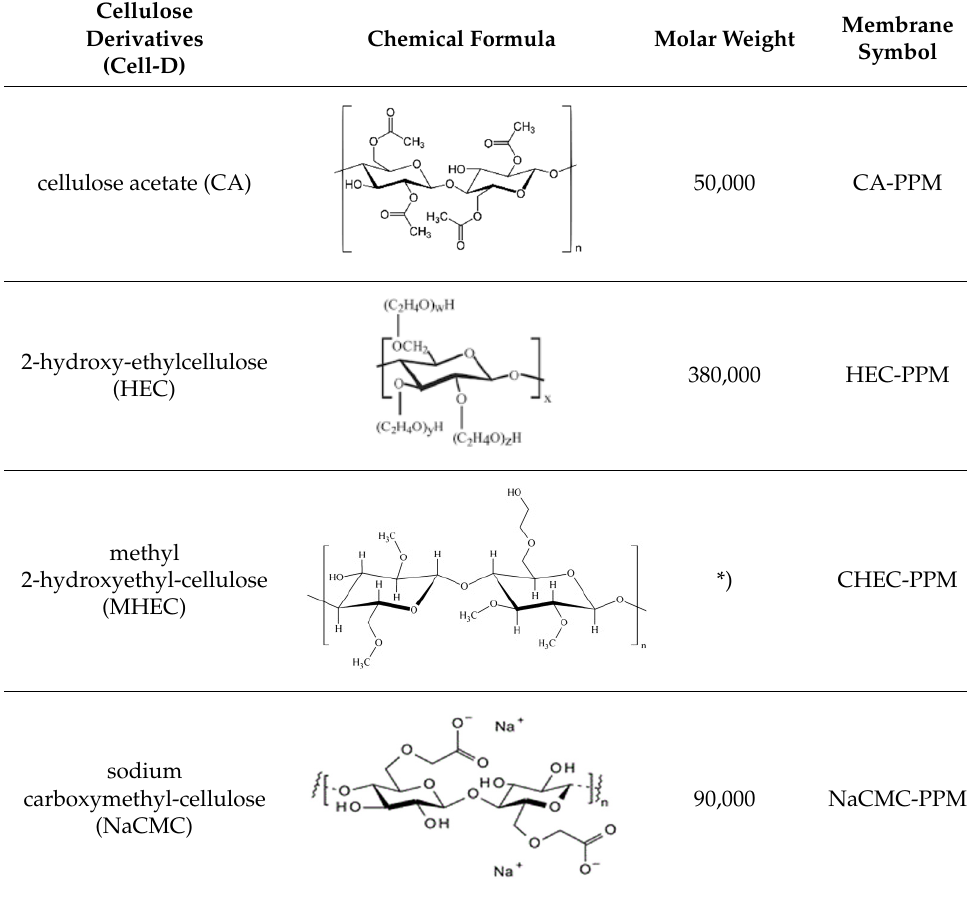
Table 2. The characteristics of cellulosic derivatives under test and the membranes obtained.